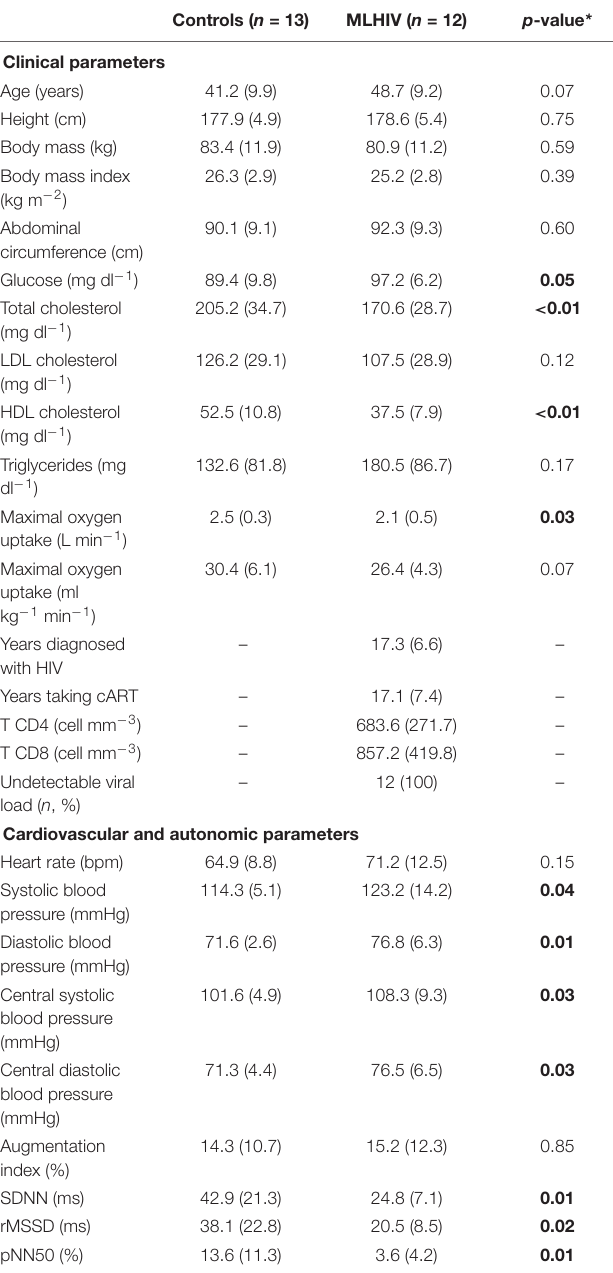
TABLE 1 | Clinical, cardiovascular, and autonomic parameters at rest in controls and men living with HIV (MLHIV). Controls ( n = 13) MLHIV ( n = 12)